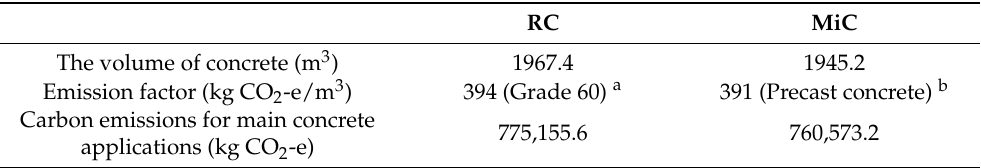
Figure 12. Comparison of layout plans using ( a ) RC and ( b ) MiC. ( a ) Typical layout for original Model 1. ( b ) Proposed MiC layout based on BIM. Table 7. Comparison of embodied carbon for RC and MiC.